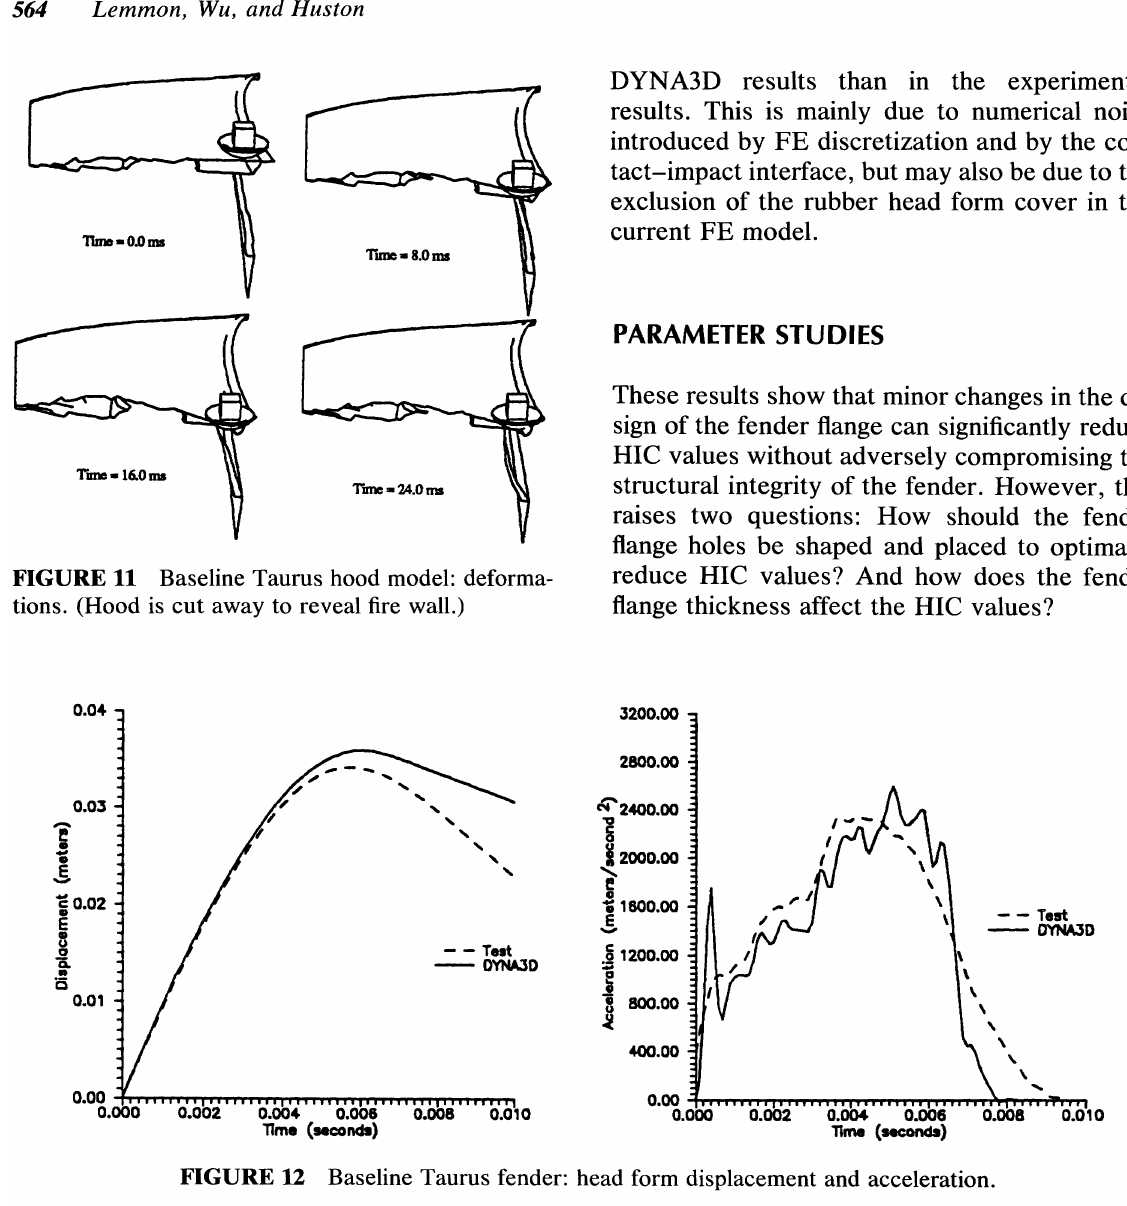
FIGURE 12 Baseline Taurus fender: head form displacement and acceleration.